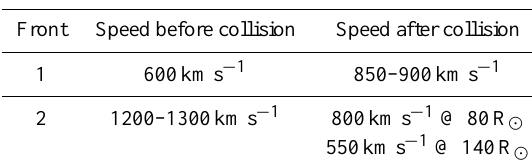
Table 1. Summary of the speeds measured by SECCHI for the two